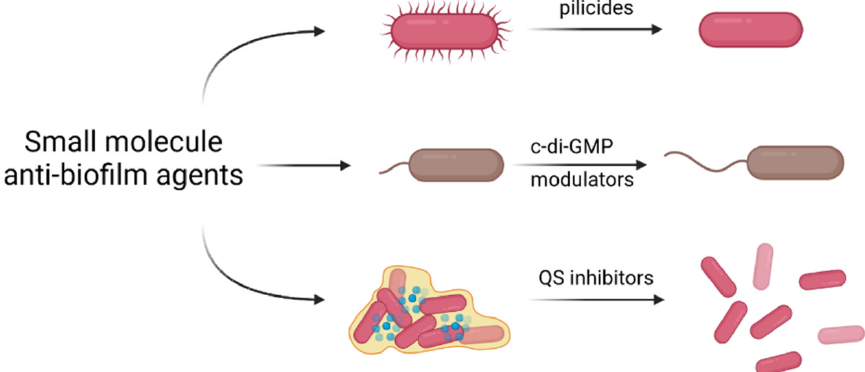
Figure 4. Schematic representation of anti ‐ biofilm mechanisms of small molecules, including inhi ‐ bition of biofilm formation by pilicides and curlicides, interfering with c ‐ di ‐ GMP (bis ‐ (3 ′‐ 5 ′ ) ‐ cyclic bition of biofilm formation by pilicides and curlicides, interfering with c-di-GMP (bis-(3 (cid:48) -5 (cid:48) )-cyclic dimeric guanosine monophosphate) signaling, or inhibition of quorum sensing (QS). dimeric guanosine monophosphate) signaling, or inhibition of quorum sensing